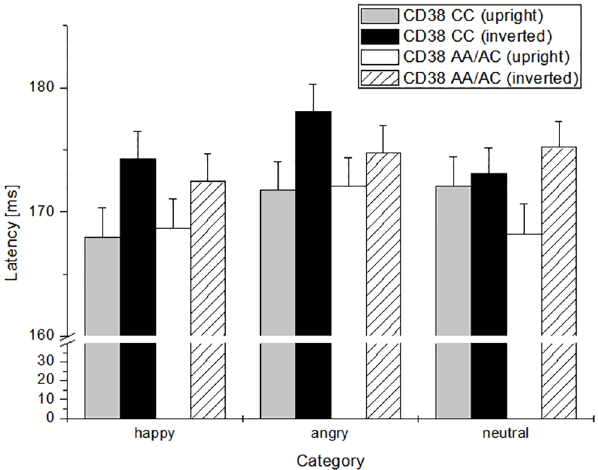
Fig 3. N170-latencies in reaction to happy, angry, and neutral upright and inverted faces in dependence of CD38-allele-frequency. Error bars reflect the standard error of the mean (SEM).